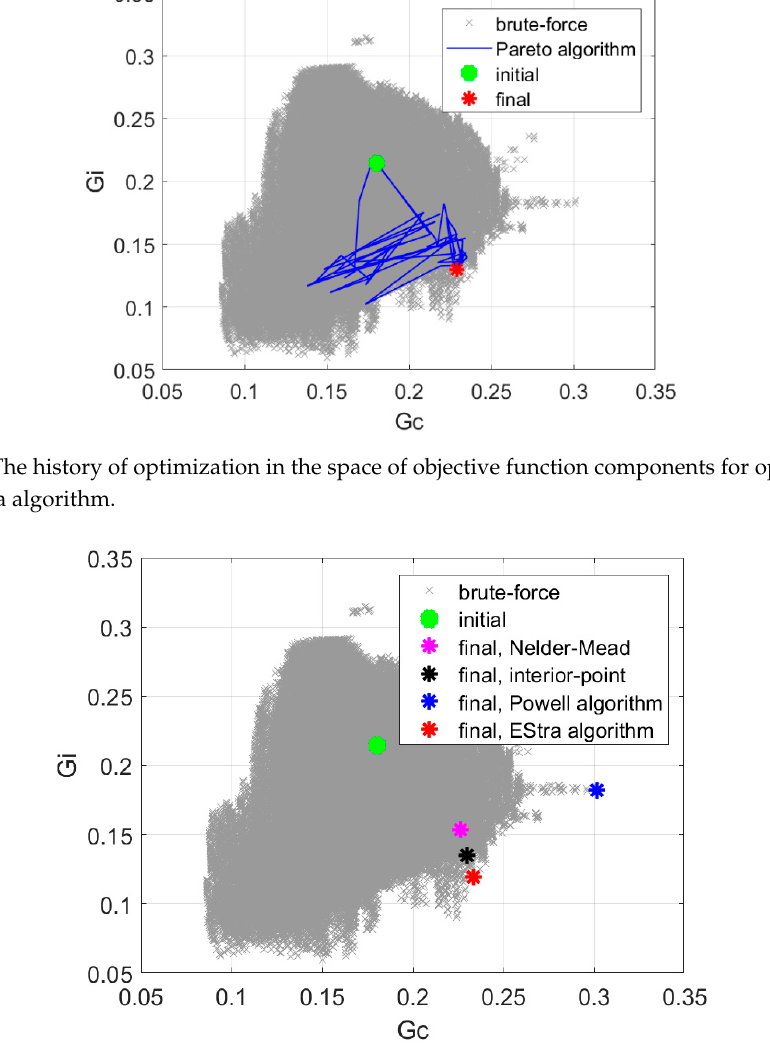
Figure 14. Solutions obtained for the single-objective min-max formulation with the Nelder–Mead, “interior-point”, Powell, and EStra algorithms, respectively. Table 2. Comparison of convergence and objective function value for several optimization algorithms.